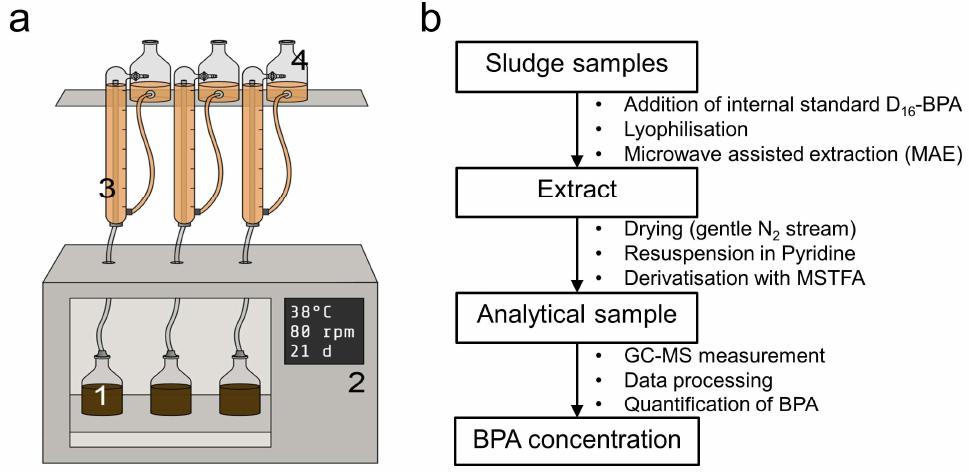
Figure 1. Experimental design: ( a ) Anaerobic batch test following German standard VDI 4630, and ( b ) analytical workflow. Inoculates were digested in bottles ( a1 ) under anaerobic mesophilic conditions (38 ◦ C) in an orbital shaker ( a2 ) connected to eudiometers ( a3 ) with levelling bottles ( a4 ) to allow quantitative and qualitative measurements of the produced biogas.